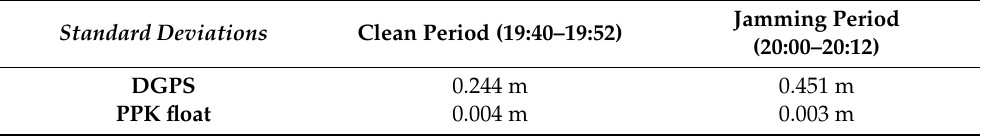
Table 4. Standard deviation for the differential GPS (DGPS) and PPK float solutions using GPS L1 signals from selected GPS satellites (G07, G10, G16, G20, G21, G26, and G27) during the jamming incident and during a similar jamming free period leading up to the